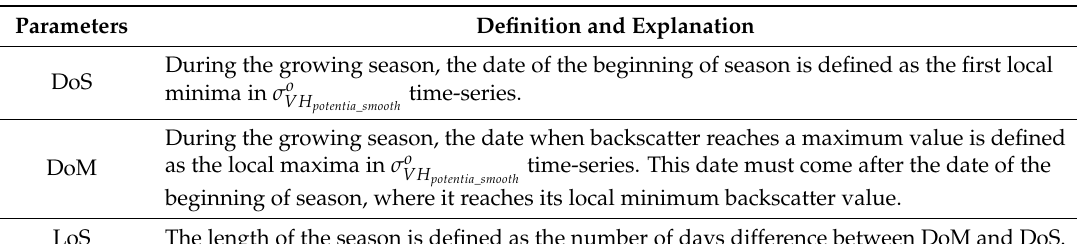
Table 1. Phenological parameters for the rule-based